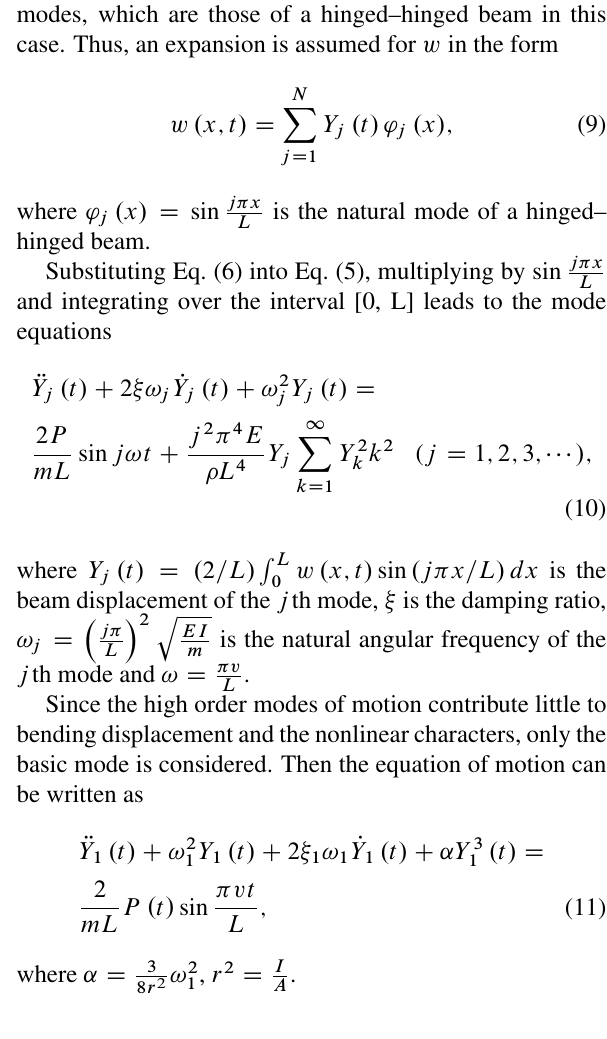
Figure 2. Vehicle